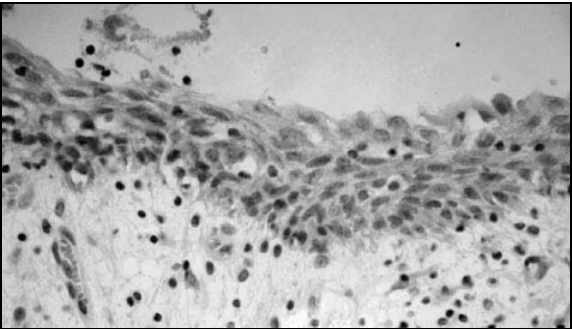
Figura 1 – Marcação difusa da MMP-1 no revestimento epitelial e focal na cápsula de cisto radicular residual (SABC,